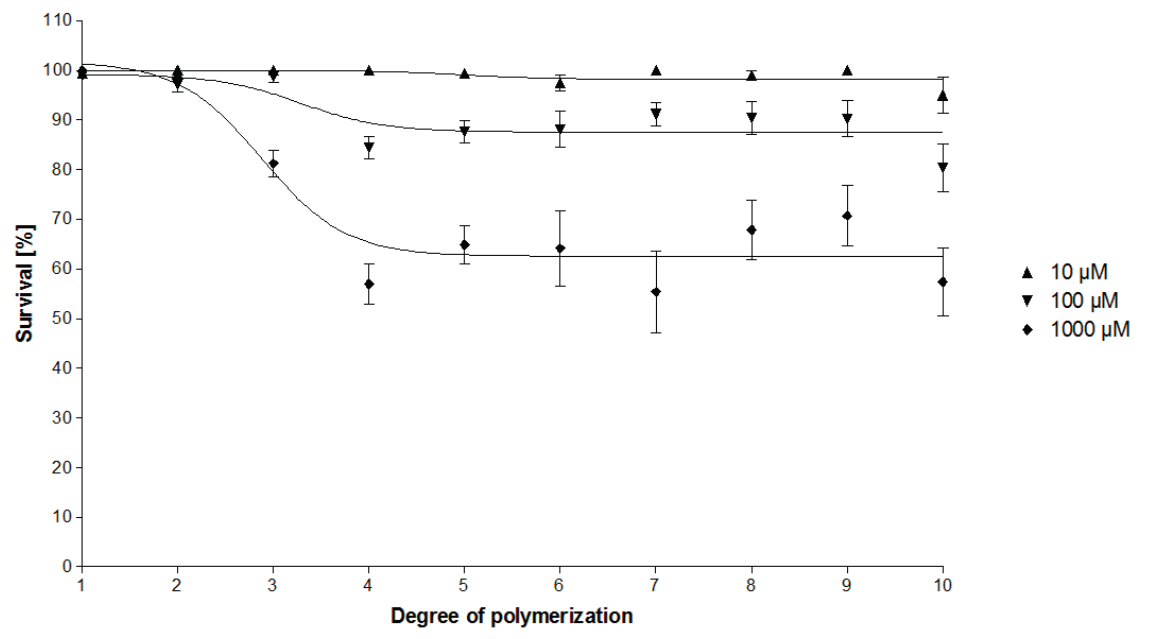
Figure 6. Anthelmintic activity as a function of the DP of the OPC from C. mucronatum . The survival rate of the worms decreases up to DP4, but no further decrease can be observed up to